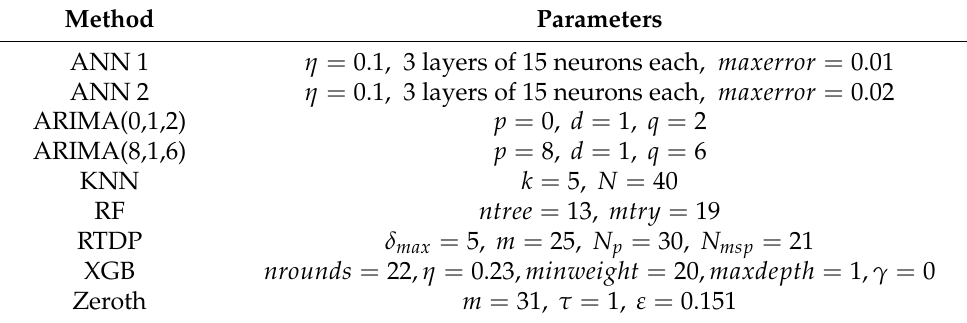
Figure 3. Results of a series of predictions designed to empirically determine the optimal parameters of the RTDP method. The time series of power energy consumption, shown in Figure 2, was used to calculate these results. The numbers at the nodes represent the value of δ max . The number of patterns and the number of the most successful patterns were set to N p = 30 and N msp = 21 for the whole series. The RTDP method is (in this case) most accurate when the parameters δ max = 5 and m = 25 are set. Table 1. Summary of the used parameter values of the compared